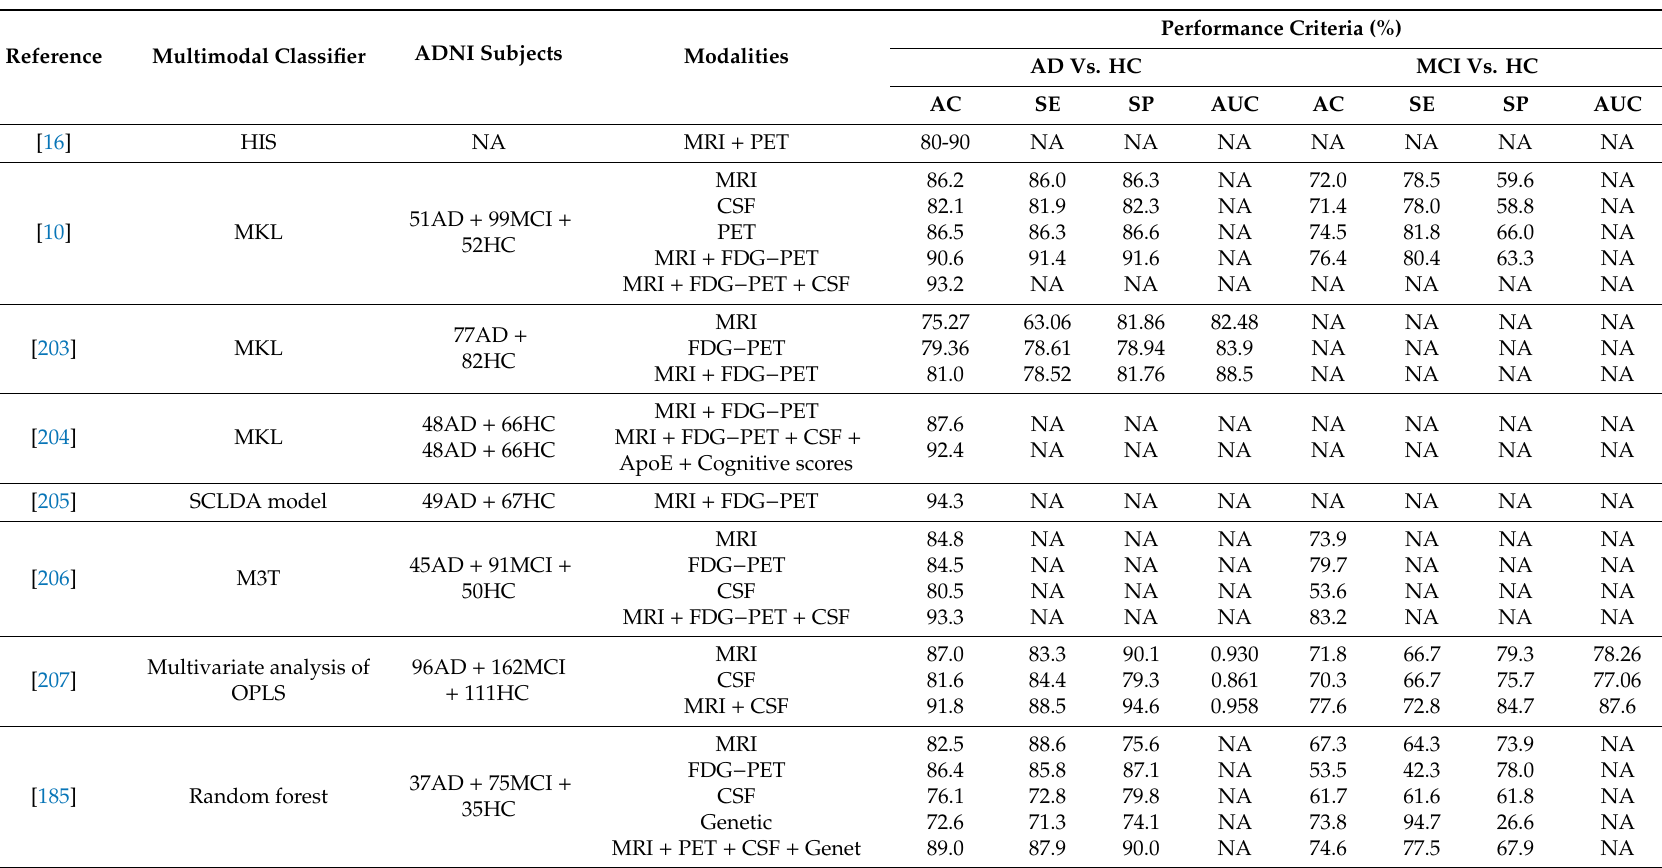
Table 5. Some works described in the literature related to the CAD systems of Alzheimer disease through multimodal fusion with comparison of performance of single-modal and multimodal classification methods using 10-fold cross-validation. The e ffi ciency of the proposed multimodal CAD system is demonstrated by estimating the percentage of the following performance measures: Sensitivity (SE), which represents the true positive rate; specificity (SP), which estimates the true negative rate; and accuracy (AC), which determines the proportion of true results in the database, whether true positive or true negative. For the same purpose, for some work, the area under ROC curve (AUC) value was estimated which determines the diagnostic validity by combining sensitivity and